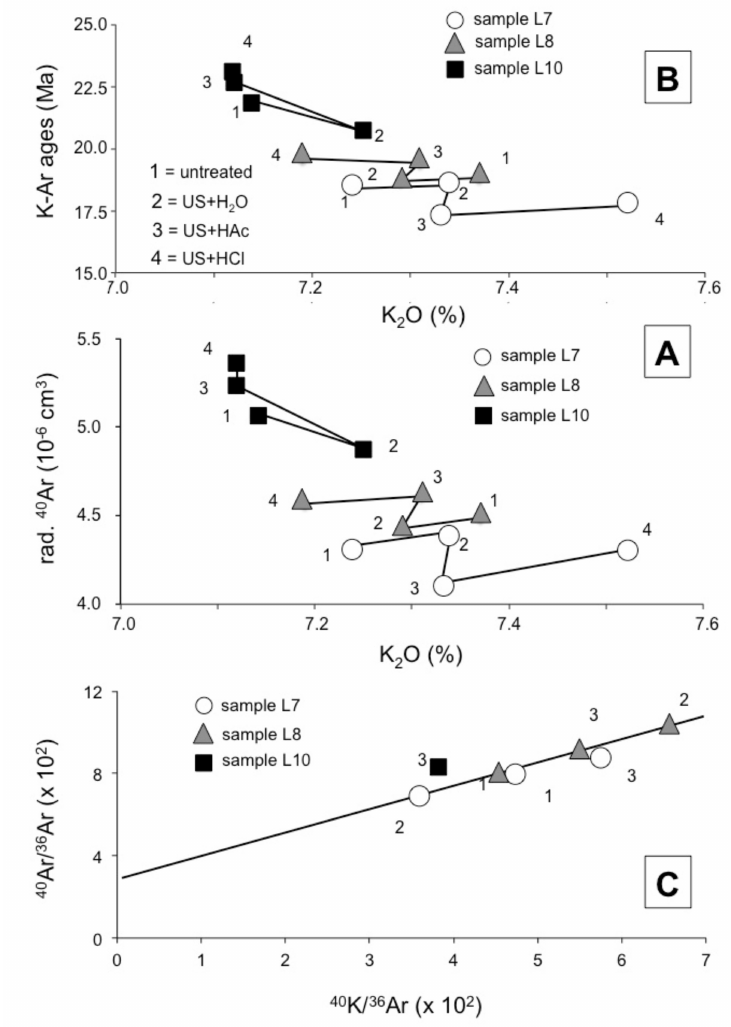
Figure 3. ( A ) Diagram displaying the content of radiogenic 40 Ar relative to K 2 O in the untreated and leached glauconite separates; ( B ) the same for the K–Ar age values (in Ma) relative to the K 2 O content; ( C ) 40 Ar/ 36 Ar vs. 40 K/ 36 Ar isochron diagram of the untreated and leached glauconite